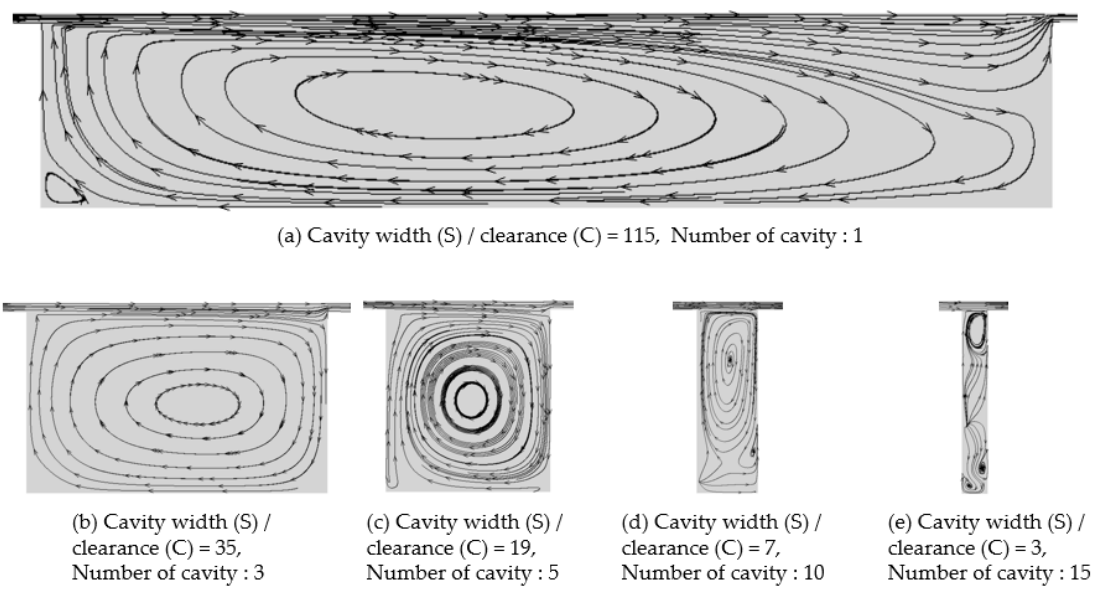
Figure 15. ( a – e ) The effect of the cavity width to the clearance ( S/C ) ratio on the discharge coefficient of a straight-through labyrinth seal under a pressure ratio of 2 when the whole axial length is fixed.